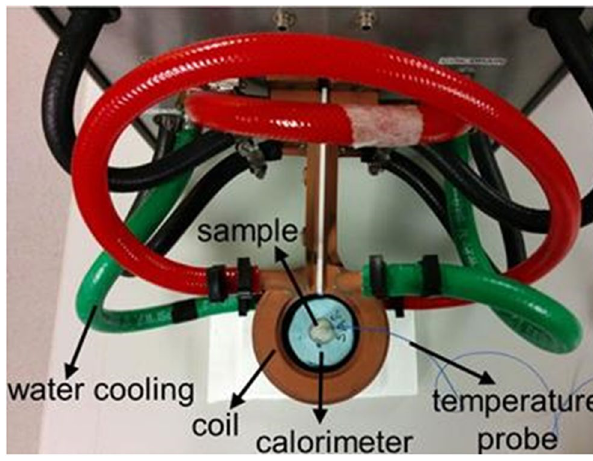
Figure 7. Experimental setup for calorimetric SLP